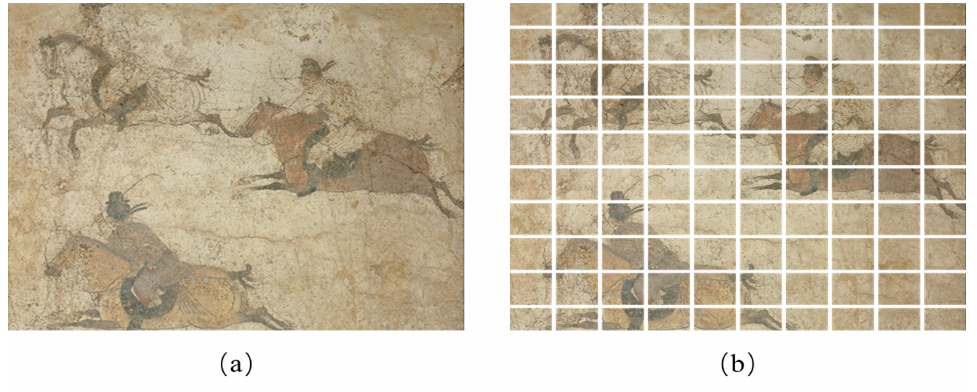
Figure 7. ( a ) Mural images; ( b ) images clipped from mural